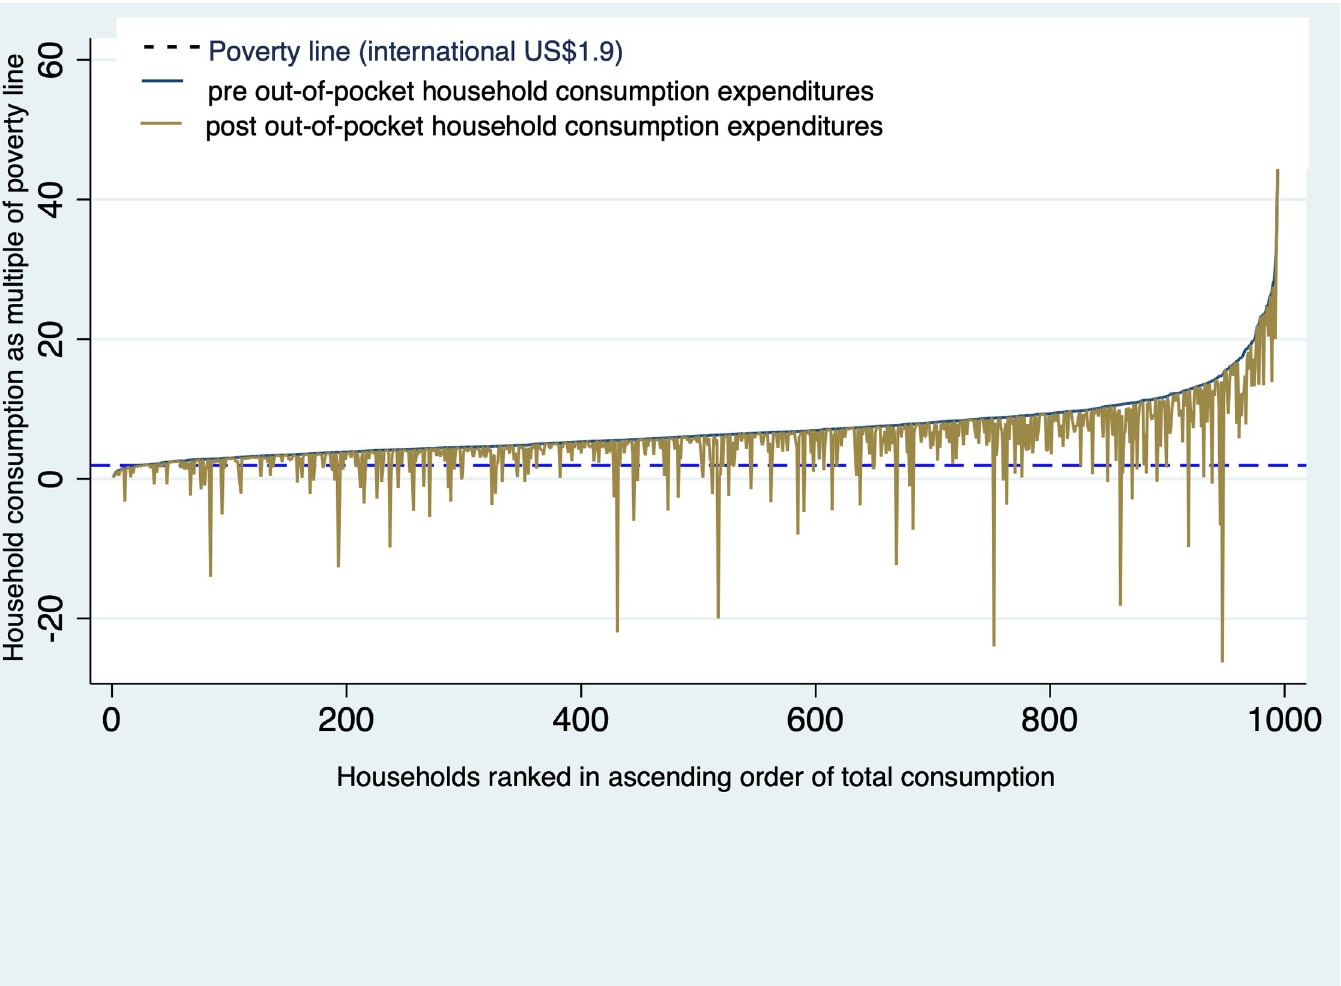
Fig 2. Impact of out-of-pocket expenditures associated with treatment of vaccine-preventable diseases on monthly household consumption expenditures.